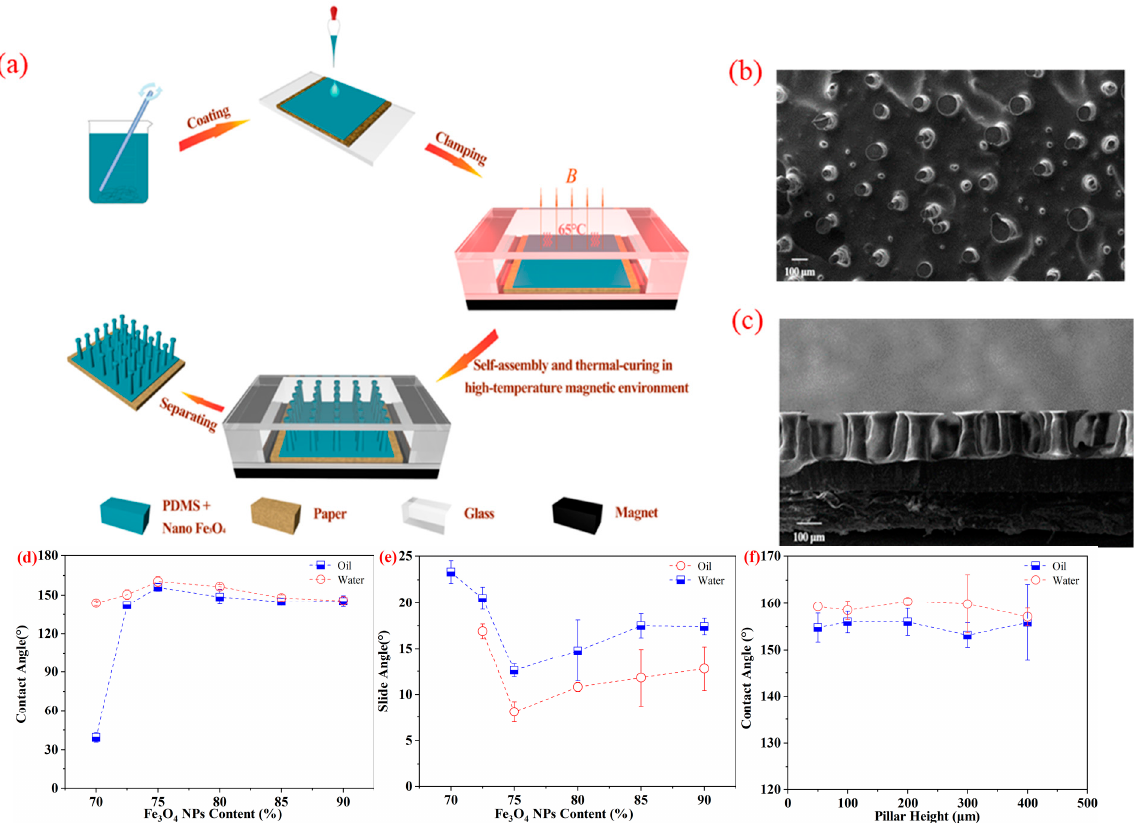
Figure 1. ( a ) Schematic illustration of the fabrication of a MLPA with mushroom-like microstruc- tures ( b , c ) SEM images of the top view and side view of the as-prepared MLPAs. ( d ) OCAs and WCAs on the surfaces with different Fe 3 O 4 NPs content. ( e ) The slide angles of water and oil on the surfaces with different Fe 3 O 4 NPs content. ( f ) Relationships between the CAs (oil, water) and pillar